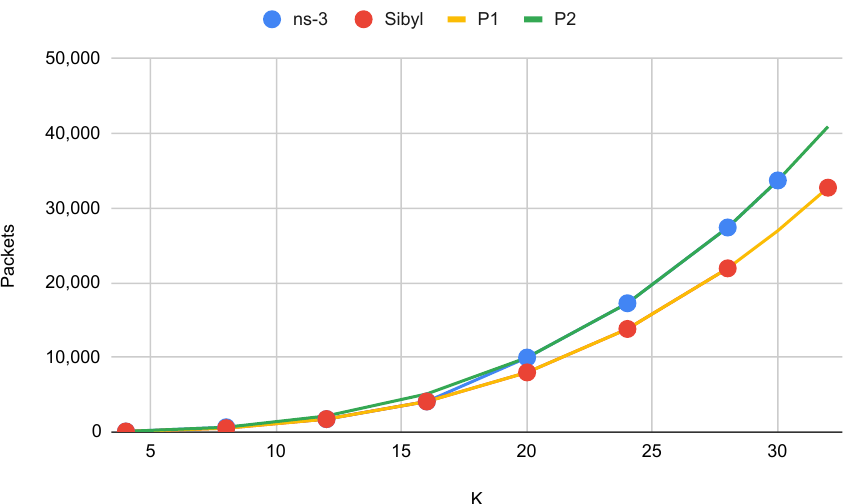
Figure 5. Evolution of the results of ns-3 and Sibyl for the Leaf failure scenario, in comparison with the evolution of the polynomials P 1 = k 3 − k and P 2 = 5 k 3